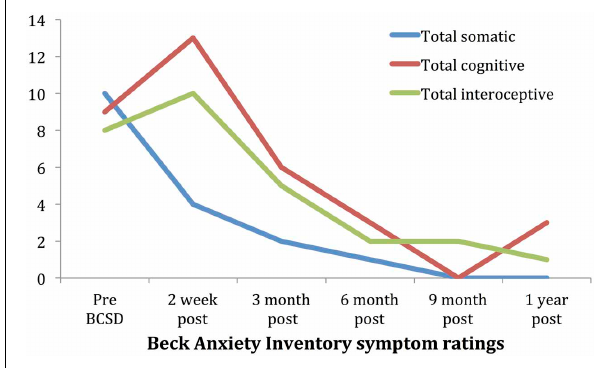
FIGURE 2 | Time course of Beck Anxiety Inventory somatic, cognitive and interceptive symptoms in Case